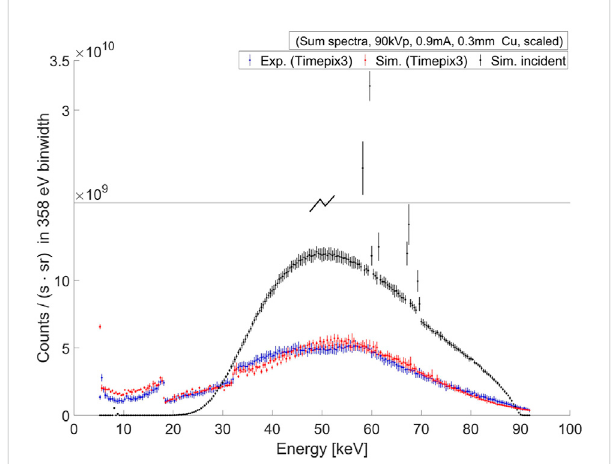
FIGURE 1 A comparison between the experimental and simulated sum- spectra of the excitation beam for the Gd case (with 90 kV tube voltage,0.9 mAtubecurrent,0.3 mmcopper fi lter)isshownhere.The experimental measurements (blue) were taken using the Timepix3 detector, and simulations (red) were performed using MC (Geant4) particle transportwith the Timepix3 sensor charge-transport and digitization model of the read-out electronics. The simulated incident sum-spectrum is obtained at the entrance surface of the detector (black) through surface fl ux scoring of the incident gamma tracks. Both the measured and simulated spectra are scaled by radiometric correction factors, as neither a physical measurement of directhigh- fl uxispossiblebyTimepix3detectors,norasimulationofa large number of particles with Geant4 is computationally